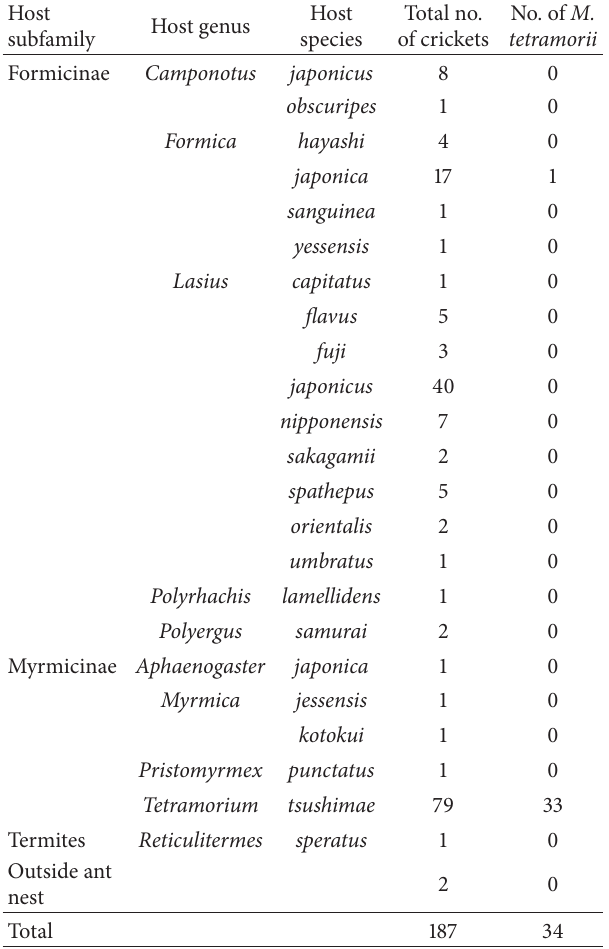
Table 1: Host ant species investigated and numbers of Myrme- cophilus spp. and M. tetramorii crickets